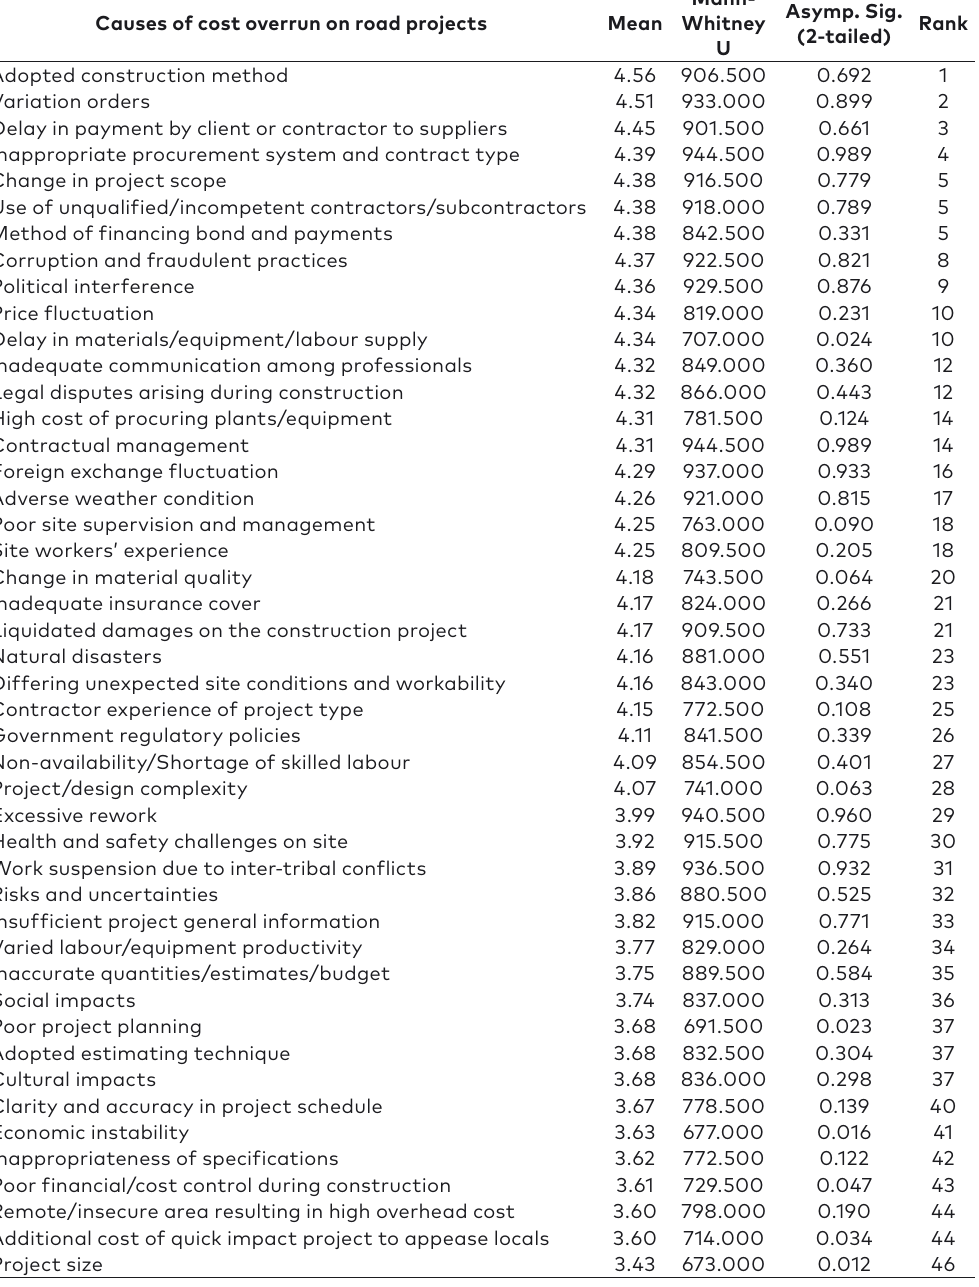
Table 3. Factors causing cost overrun on road